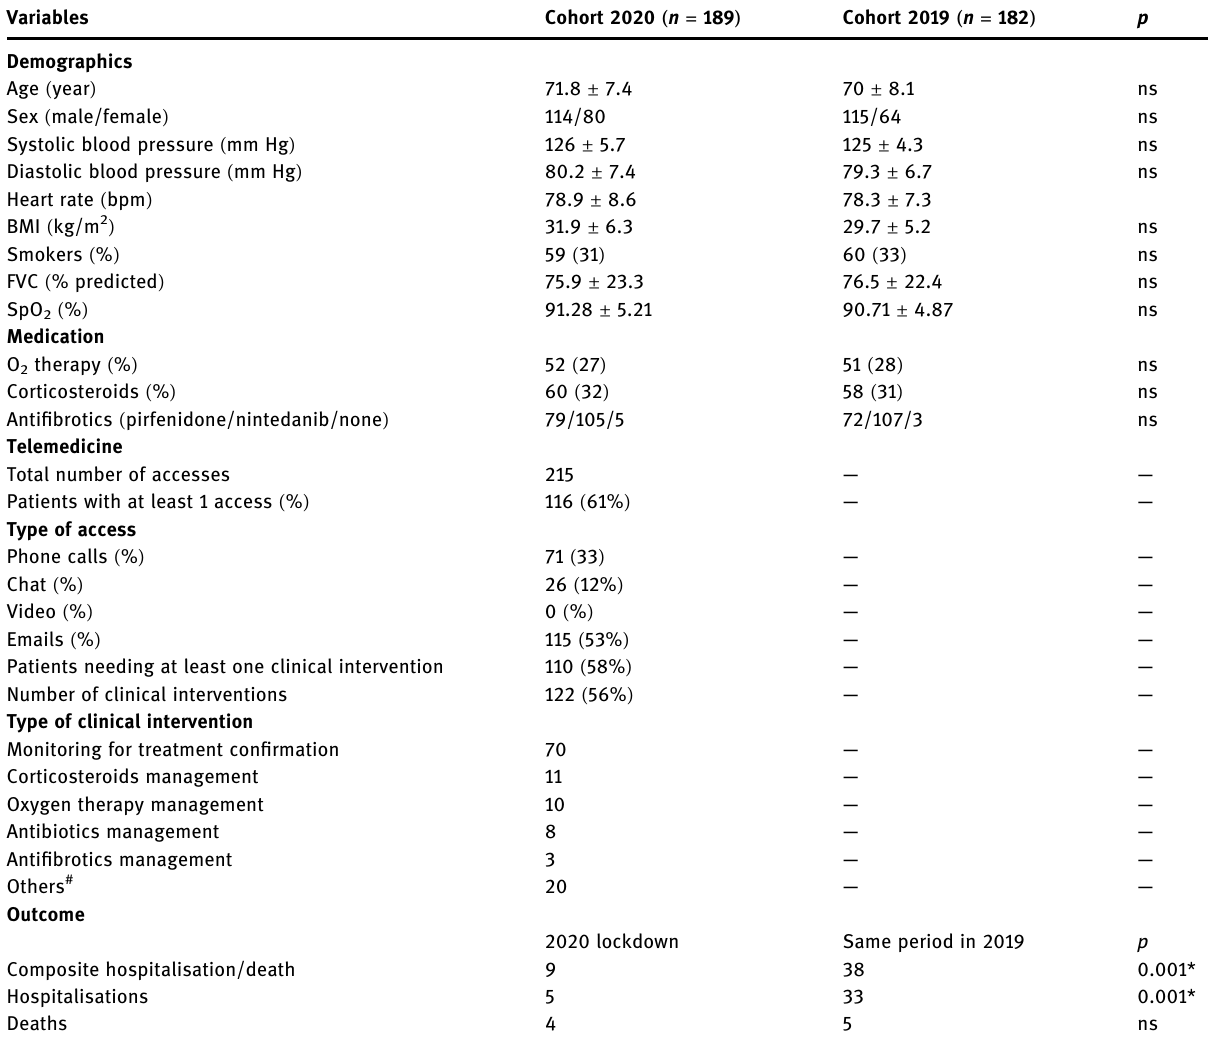
Table 1: Demographic characteristics at baseline, telemedicine data, and outcomes